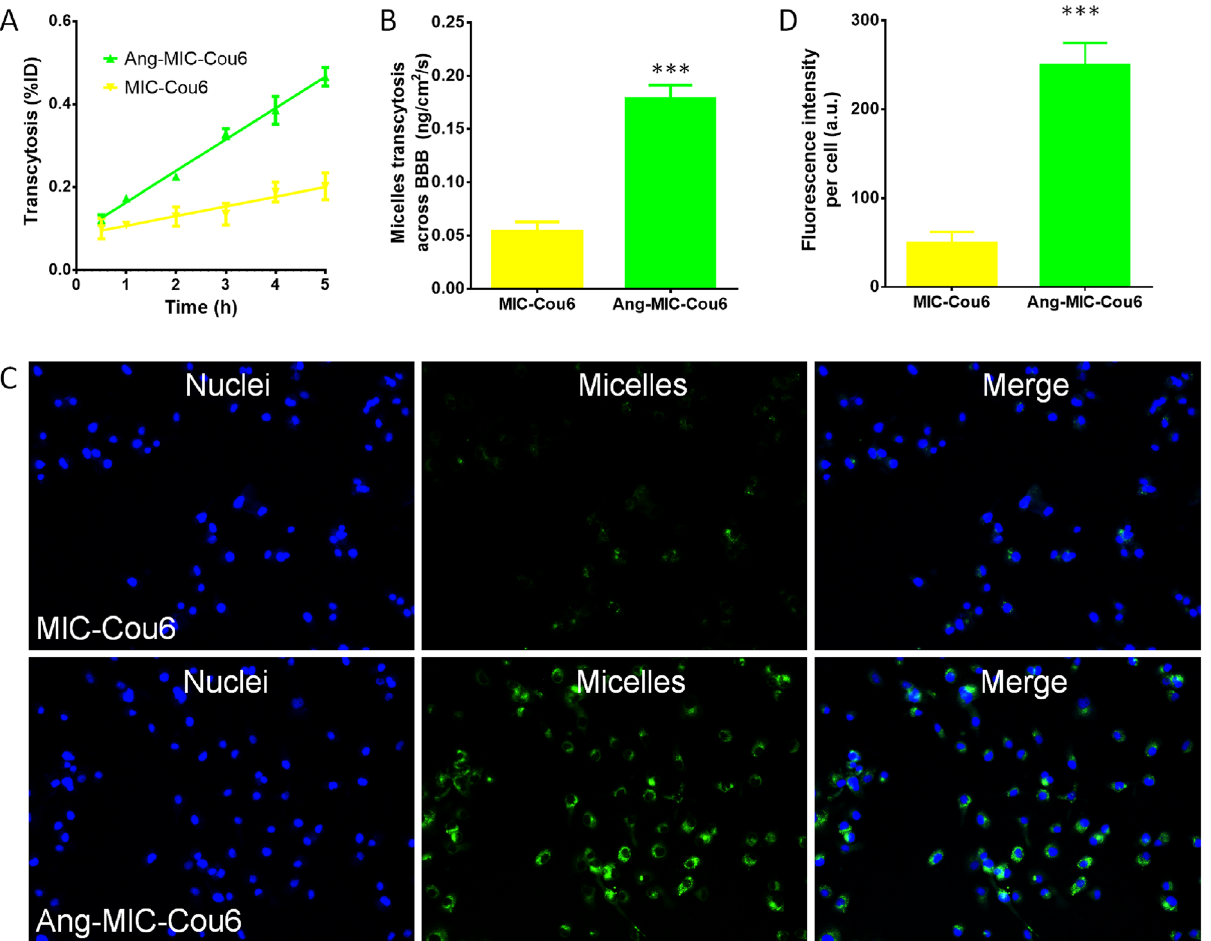
Figure 3. Transport of coumarin-6-labeled Ang-MIC acrossed the BBB model in vitro. ( A ) The signal of micelles transported across the BBB was plotted with time. ( B ) Transport rate of micelles acrossed the BBB. The uptake of micelle by Skbr-3 cells in the receptor cells ( C ) imaged by a fluorescence scope and ( D ) quantitatively determined by flow cytometry.